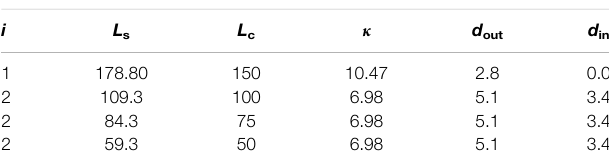
TABLE 1 | Parameters of the CTR used in this